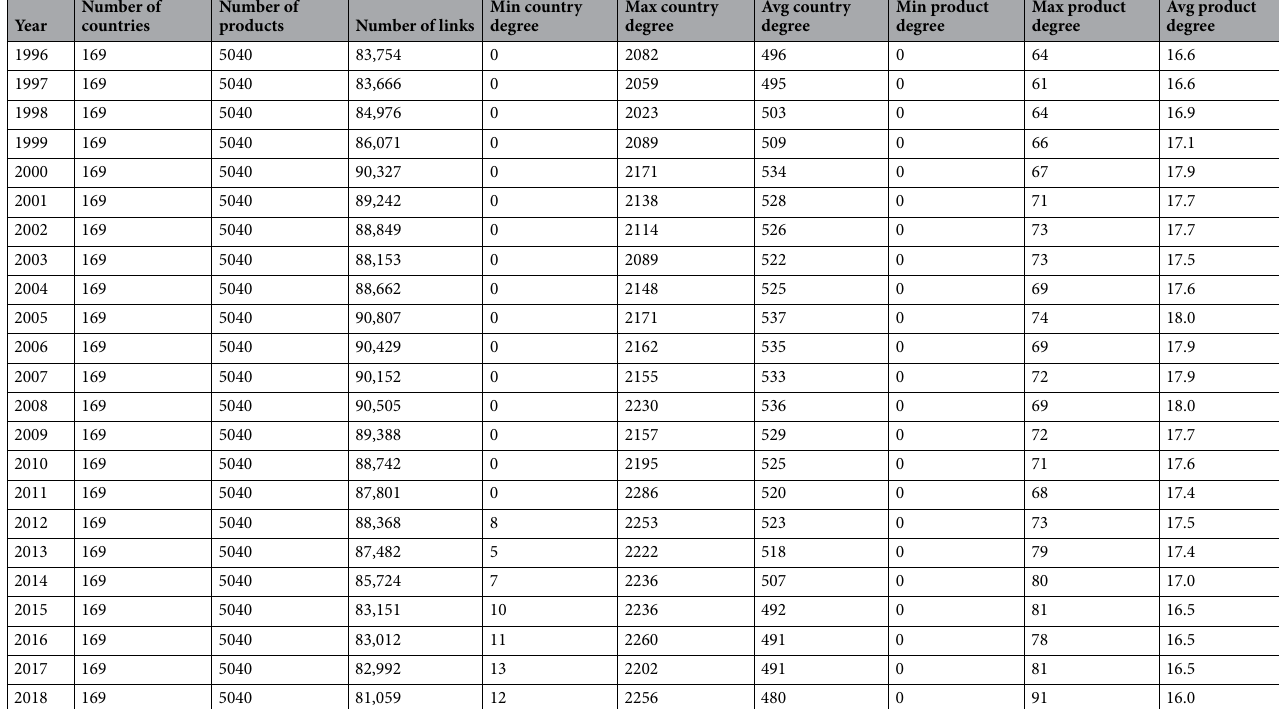
Table 2. Main properties of the country-export bipartite network over the years between 1996 and